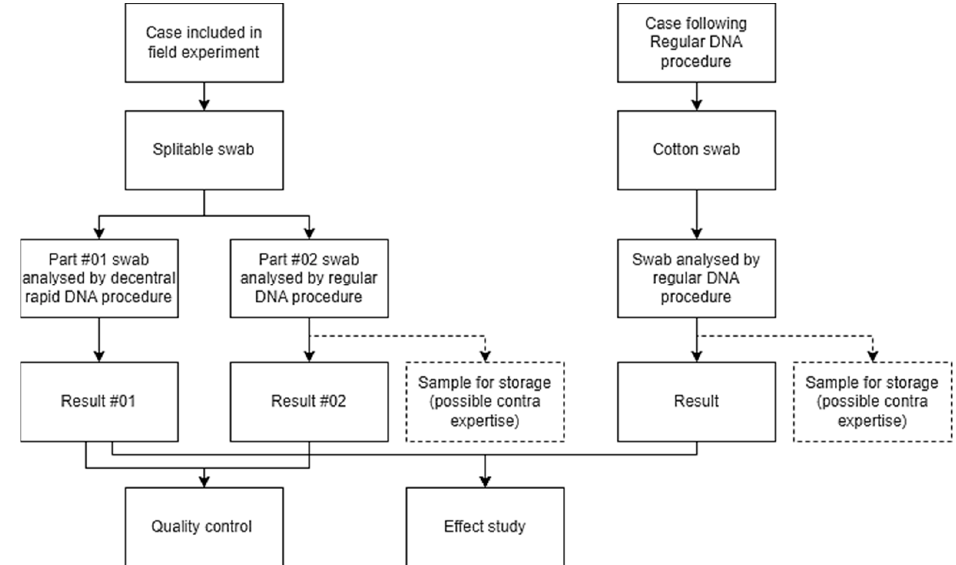
Figure 1. Overview of research design.